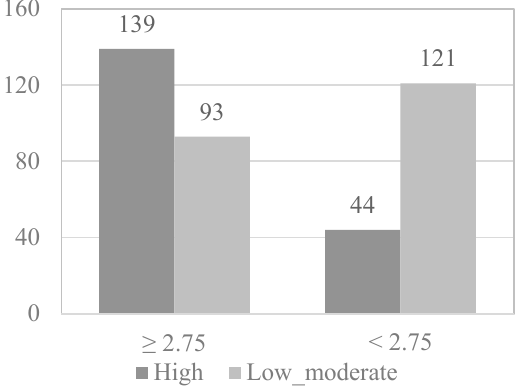
Figure 2. Activity and leisure physical activity level.